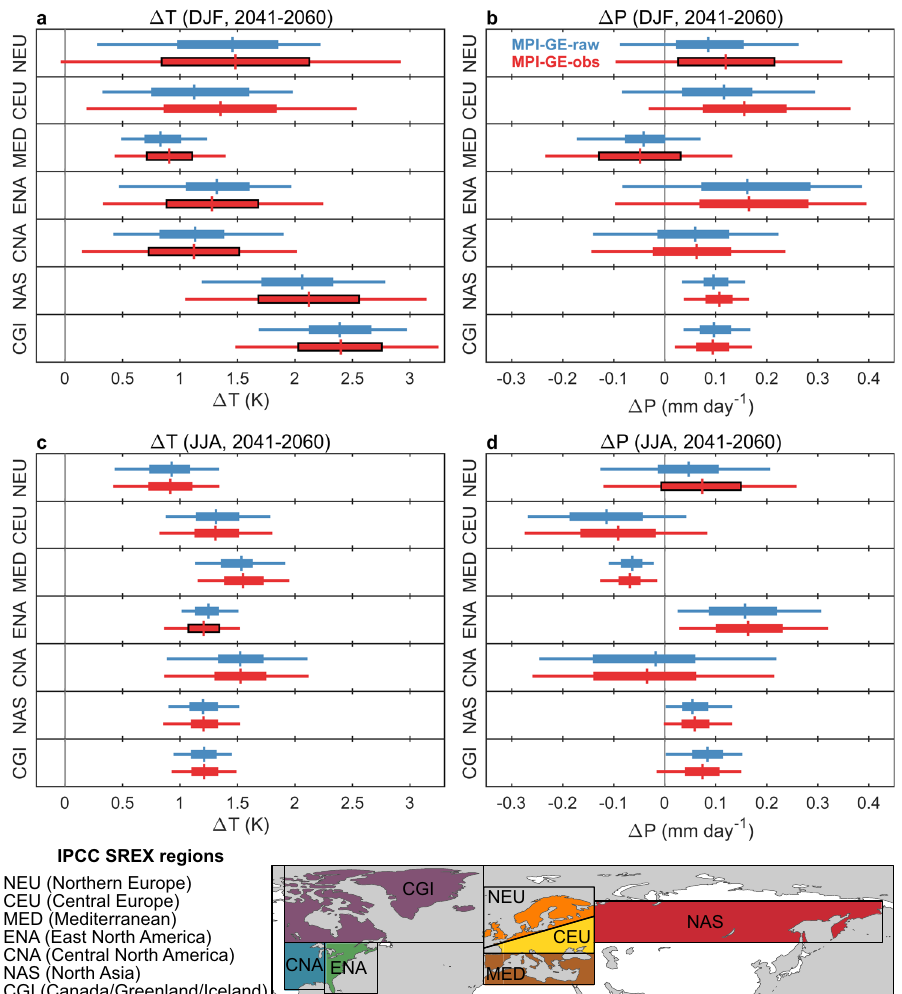
Fig. 4 Projected regional changes and the role of large-scale atmospheric circulation variability. Distributions of projected regional changes for the 2041 – 2060 mean from a 1995 – 2014 baseline period for: a Winter surface-air temperature, b winter precipitation, c summer surface-air temperature and d summer precipitation. The thin horizontal lines show the 5 – 95% range, the rectangular boxes show the interquartile range (i.e. 25 – 75%) and the vertical lines show the median change. Distributions are shown for the MPI-GE-raw ensemble (in blue) and the MPI-GE-obs ensemble (in red). The black boxes show where the interquartile range of the 2041 – 2060 projection in the MPI-GE-obs ensemble is signi fi cantly different from the respective interquartile range in the MPI-GE-raw ensemble (at the 95% level, based on a Monte Carlo resampling, see ‘ Methods ’ for further